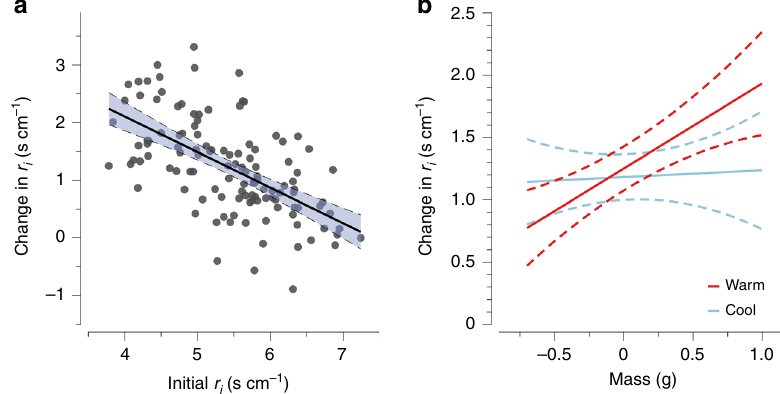
Fig. 3 Plasticity of r i in response to initial r i , mass, and temperature. a The spectrum of plastic responses in which individuals with low r i at the beginning of the experiment (Initial r i ) exhibited the greatest increase in r i by the end of the experiment and individuals with high r i did not exhibit plasticity. b Large individuals in the warm treatment (in red) increased r i to the greatest extent relative to individuals in the cool treatment (in blue). Mean responses with 95% con fi dence intervals are